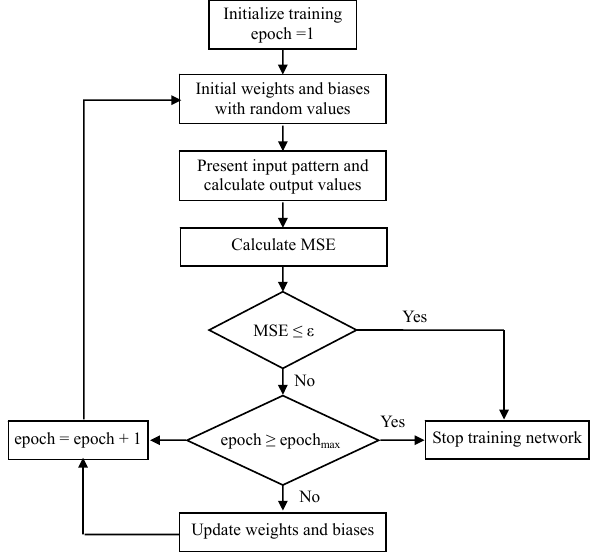
Figure 5. Back-propagation training